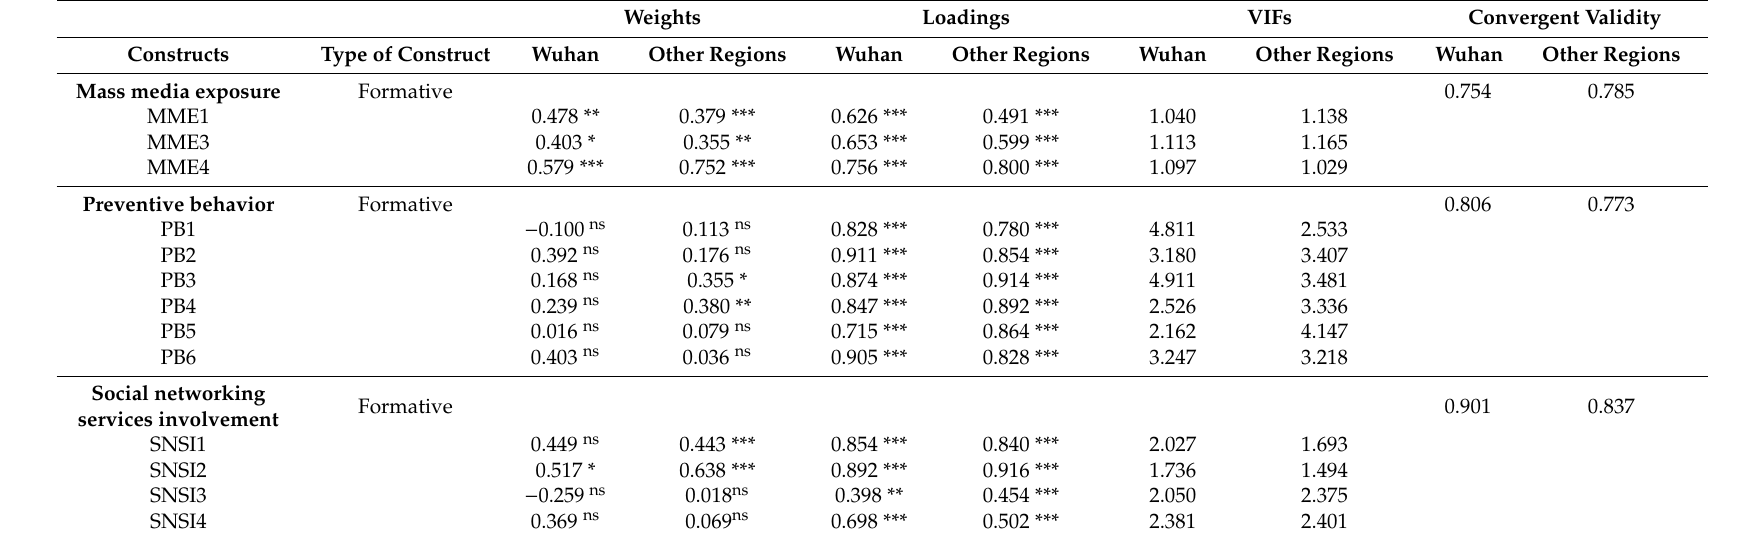
Table 5. Results for formative measurement models.